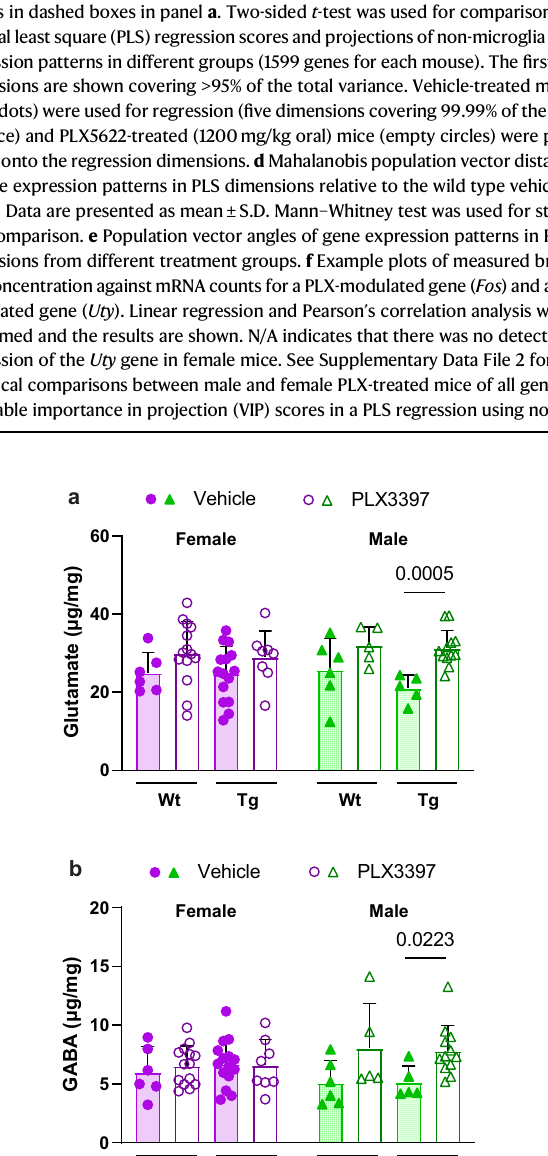
Fig.6|PLXtreatmentnormalizesgeneexpressionpro fi le,butdose-dependent